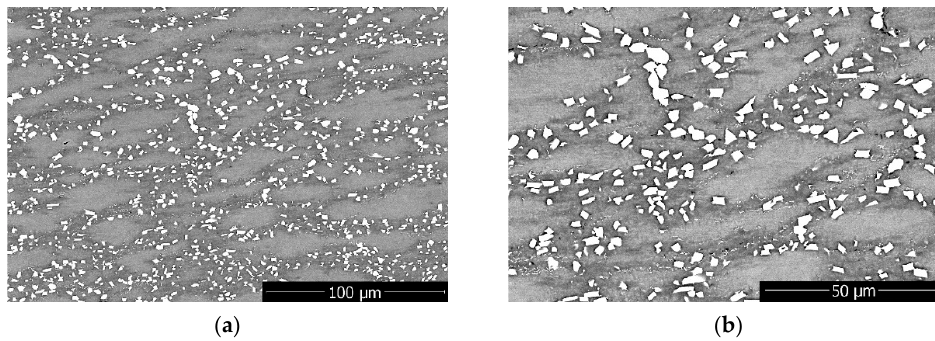
Figure 8. ( a , b ) BSE images of the microstructure of a Re 0.3 NbTiZr alloy sample after 55% compression deformation at 1000 °C.